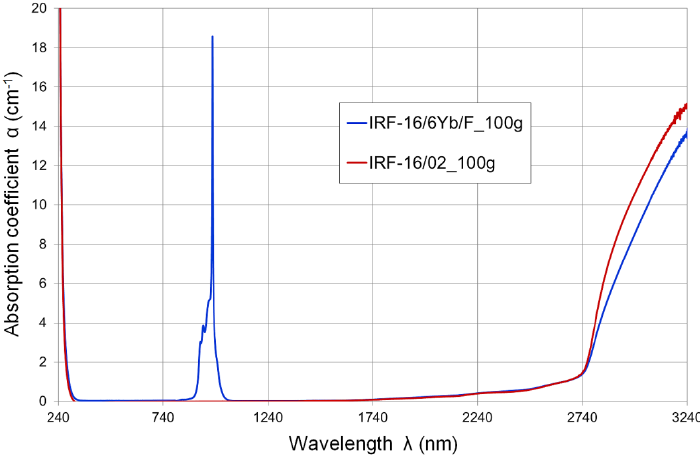
), crystallization beginning temperature ( T g